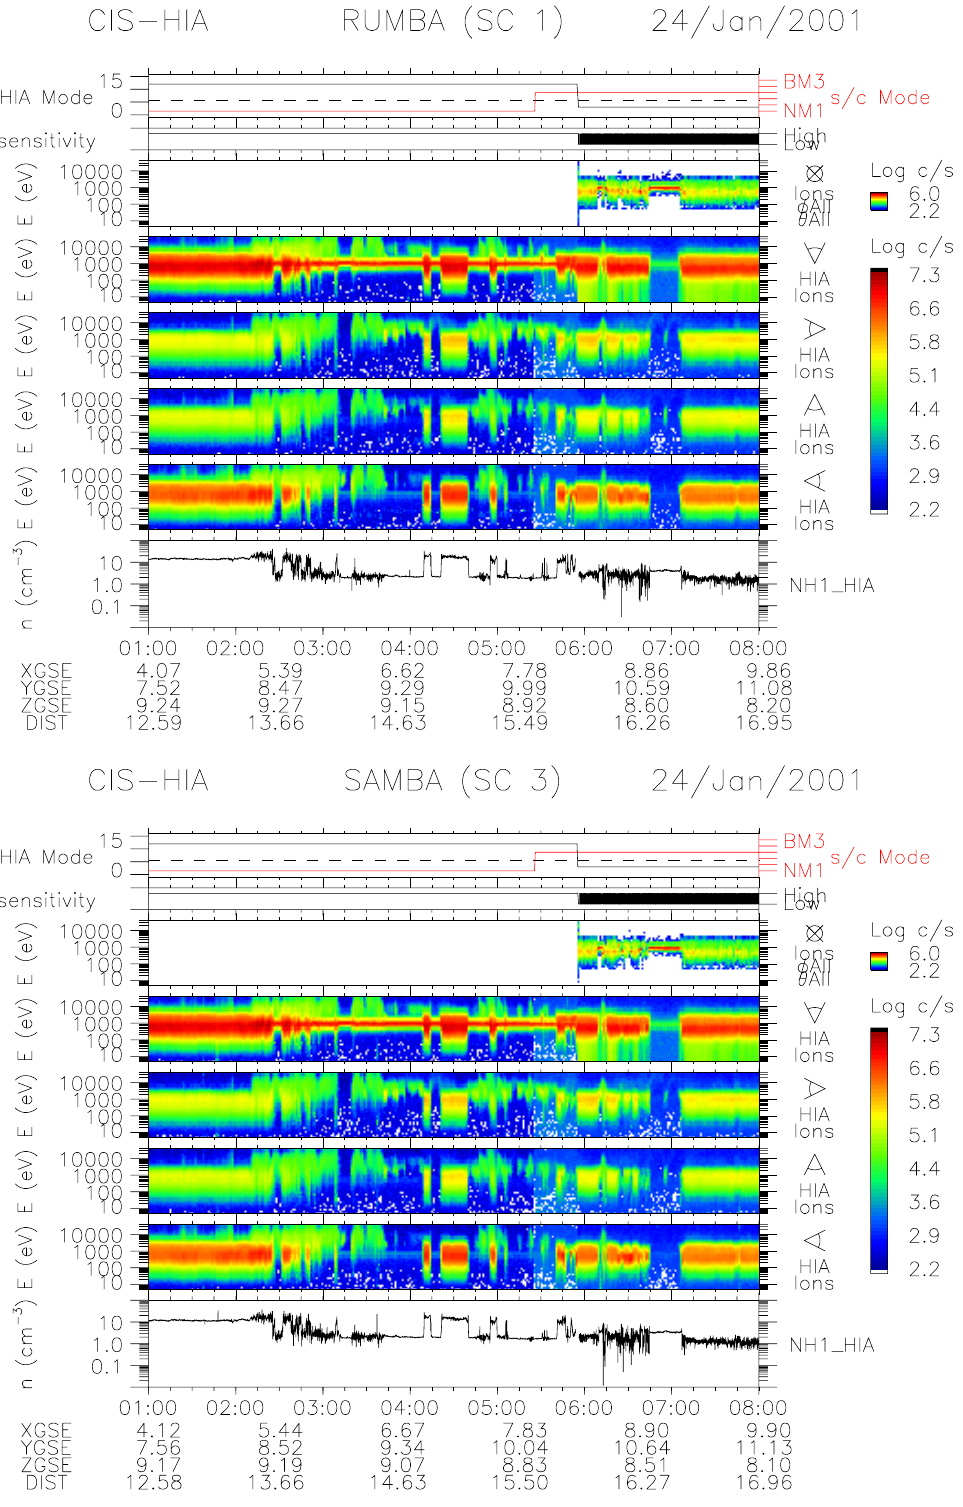
Fig. 30. Measurements of HIA with spacecraft 1 and spacecraft 3 on 24 January 2001, in the magnetosheath and the solar wind, between 01:00 and 08:00UT. Upper panel shows HIA measurements with spacecraft 1 and lower panel HIA measurements with spacecraft 3. In each panel, from top to bottom: HIA telemetry modes and sensitivities, Low Side (used only in solar wind mode) energy-time spectrogram (integrated over 45 ◦ × 45 ◦ centered in the solar wind direction), High Side energy-time spectrograms measured in the sunward, dusk, anti-sunward, dawnward looking directions, and